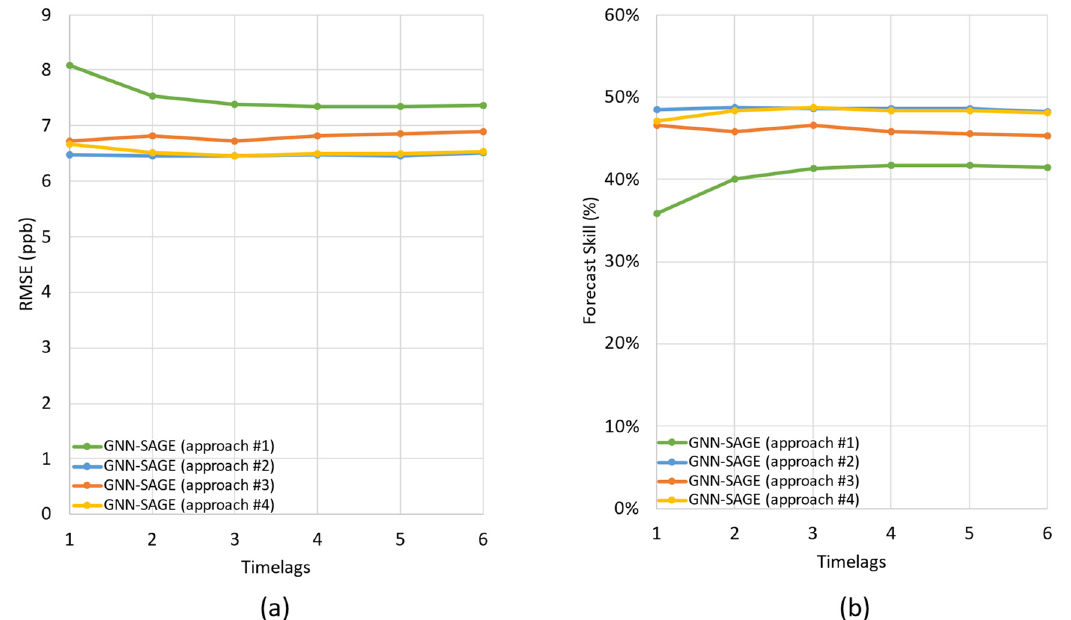
Figure 9. Effect of the different number of time ‐ lags on the model’s prediction for 3 h forecast hori ‐ zon in terms of RMSE ( a ) and Forecast Skill ( b ).